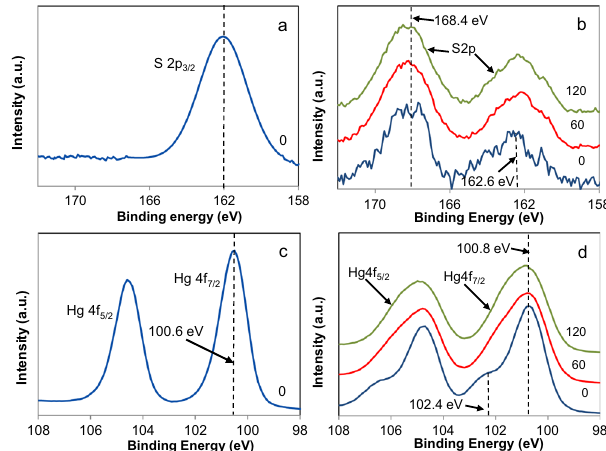
Fig. 4 XPS spectra of unaltered and UV-exposed cinnabar pigment. a , c XPS spectra showing spectra of S 2p 3/2 and Hg 4f 5/2 and Hg 4f 7/2 in unaltered cinnabar pigment, and b , d UV-aged pigment upon ion beam etching (etch time in